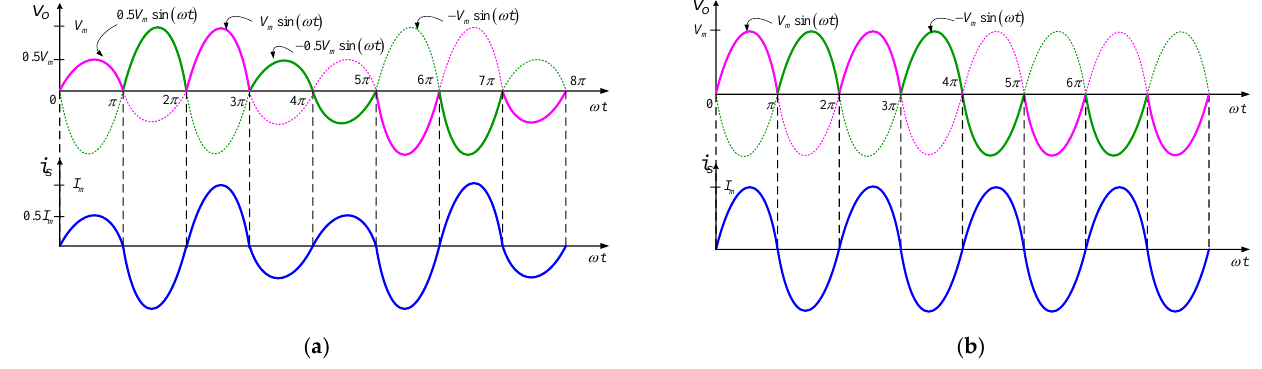
Figure 6. Output voltage of one-fourth frequency operation with respect to input for voltage ( a ) regulated form and ( b ) non-regulated form.